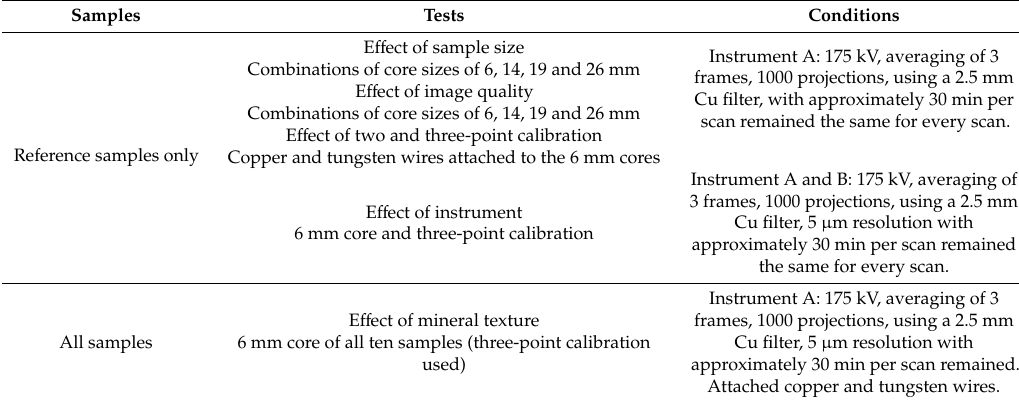
Table 2. Summarized sample scanning